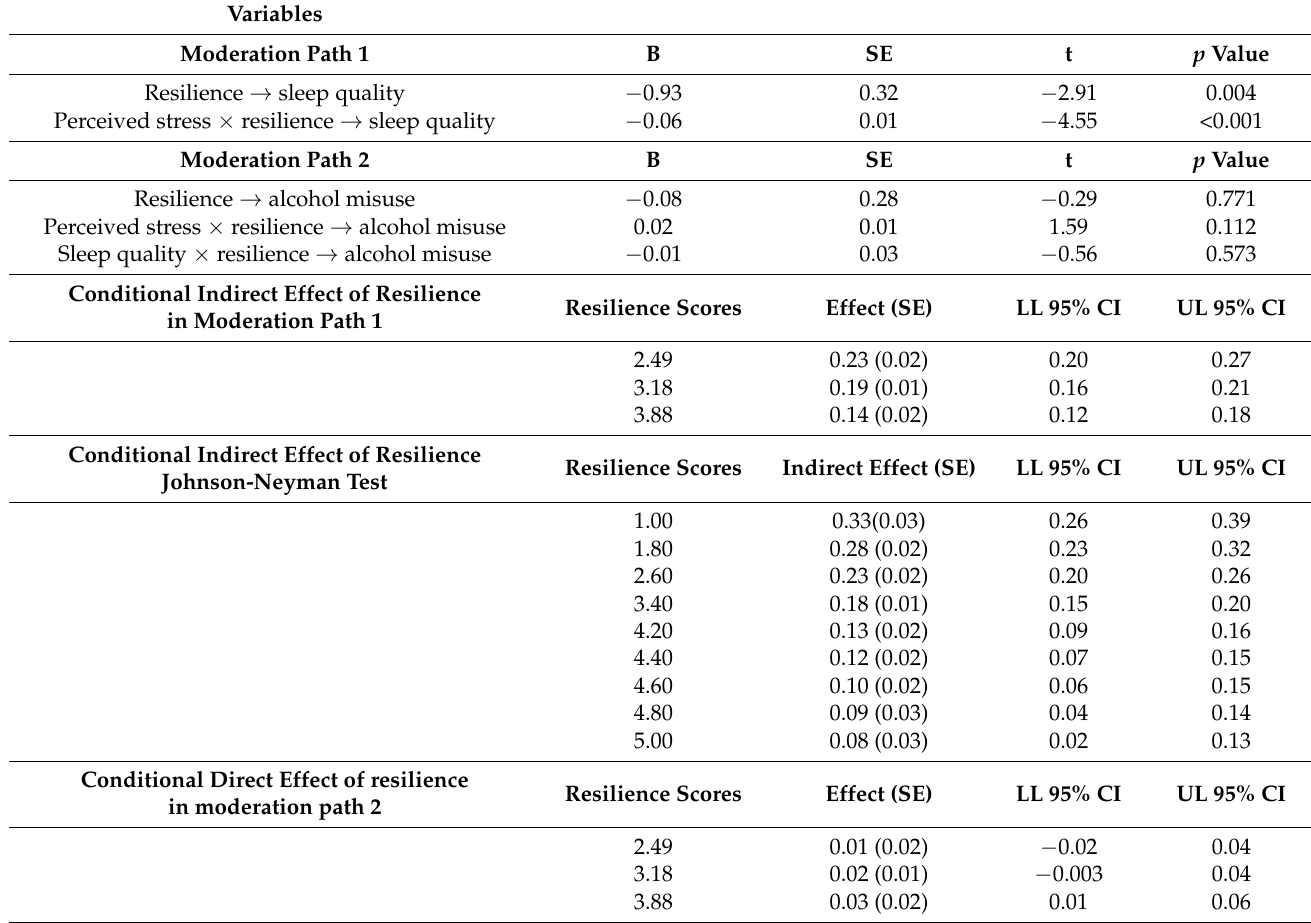
Table 11. Model 3 moderation analysis.